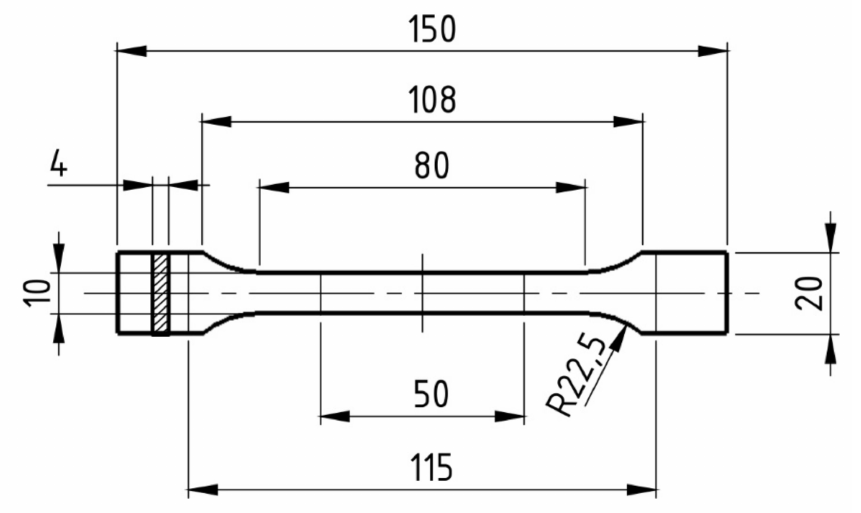
Figure 3. Dimensions of the specimen used in the uniaxial tensile test. All dimensions are given in mm (own elaboration, based on